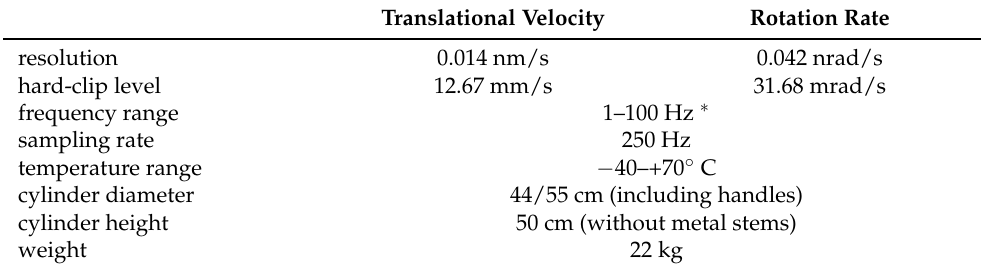
Table 1. Rotaphone-CY specifications (only parameters relevant for the